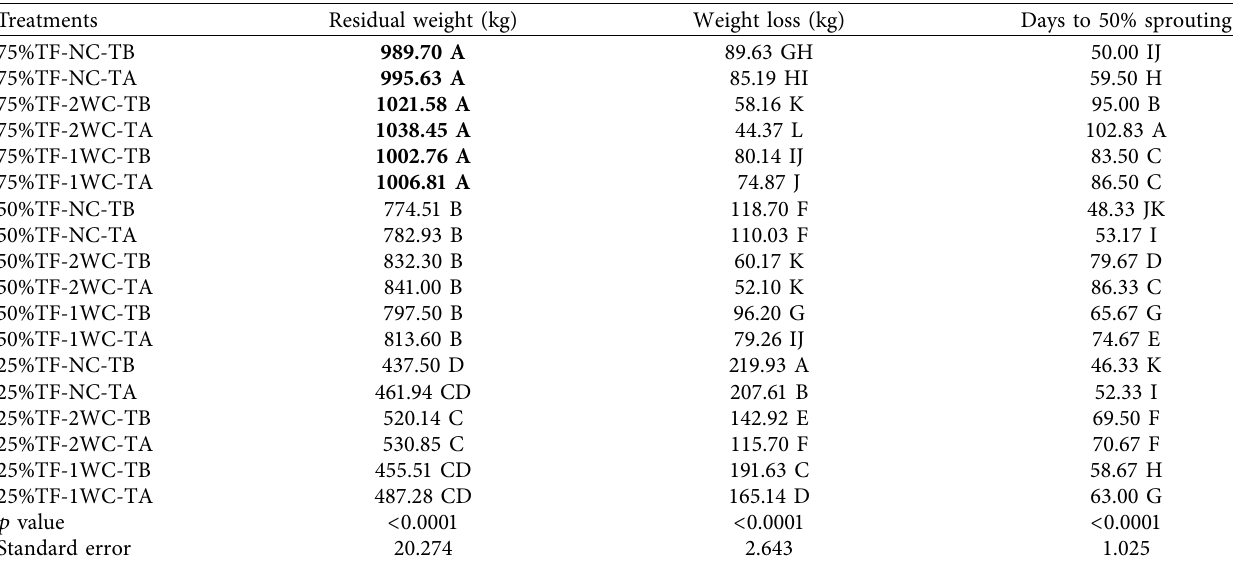
Table 3: Treatment effects on keeping quality of bulb onions.